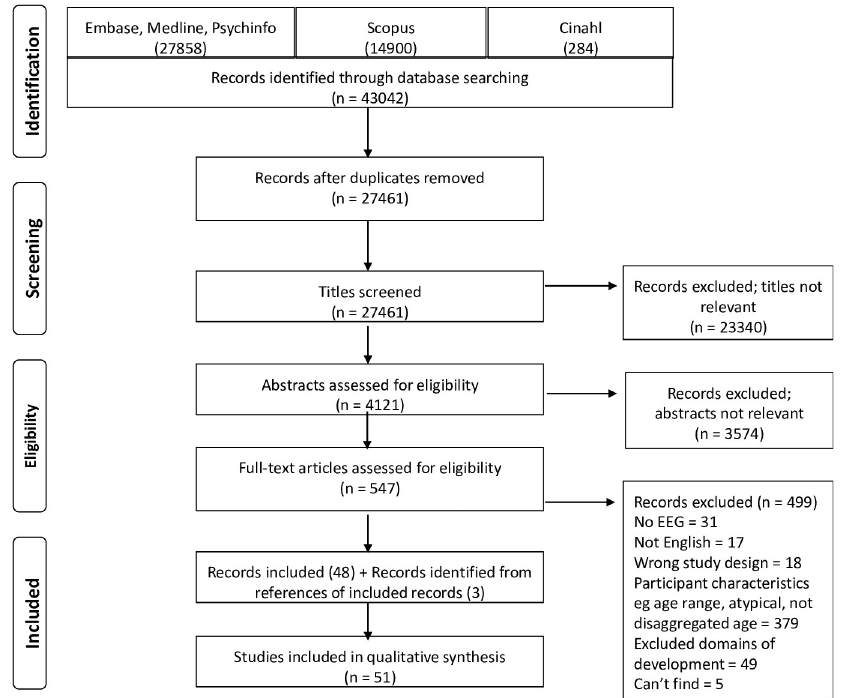
Fig 1. PRISMA flowchart—summary of the results of the search conducted in this